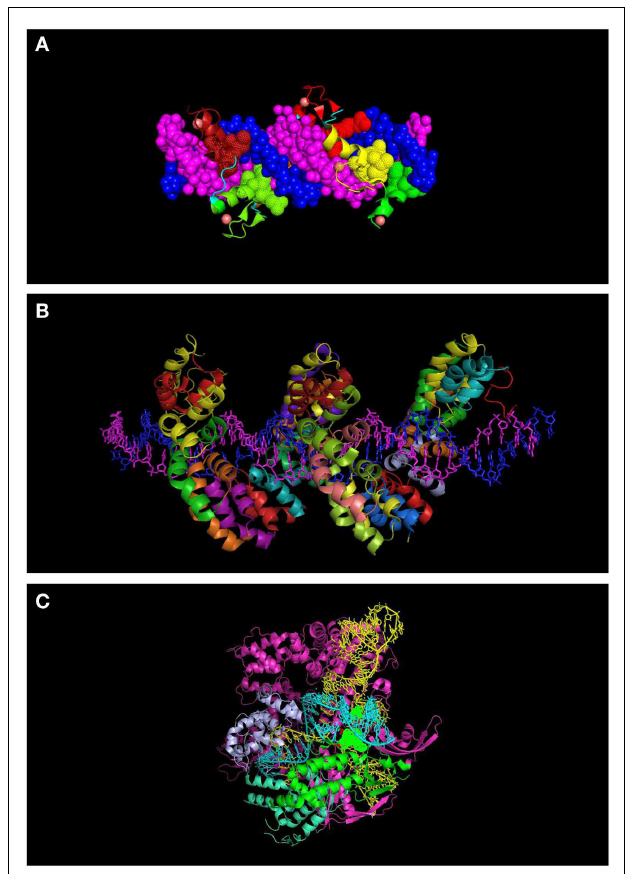
FIGURE 2 | Molecular representation of DNA-binding proteins used in genome engineering (A) 6-finger ZFP (PDB ID: 2I13) .The individual ZF domains are shown in color and the DNA in space filled mode in dark blue and magenta. (B) TALEs (PDB: 3V6T). DNA strands are shown in dark blue and magenta. Each repeat is indicated with a different color. (C) CRISPR interacting with guide RNA (yellow) and target DNA (turquoise) (PDB: 4UN5). Some of the domains of the protein are indicated (topoisomerase domain in green and nuclease domain in purple). Residues interacting with the PAM sequence are shown in space filled